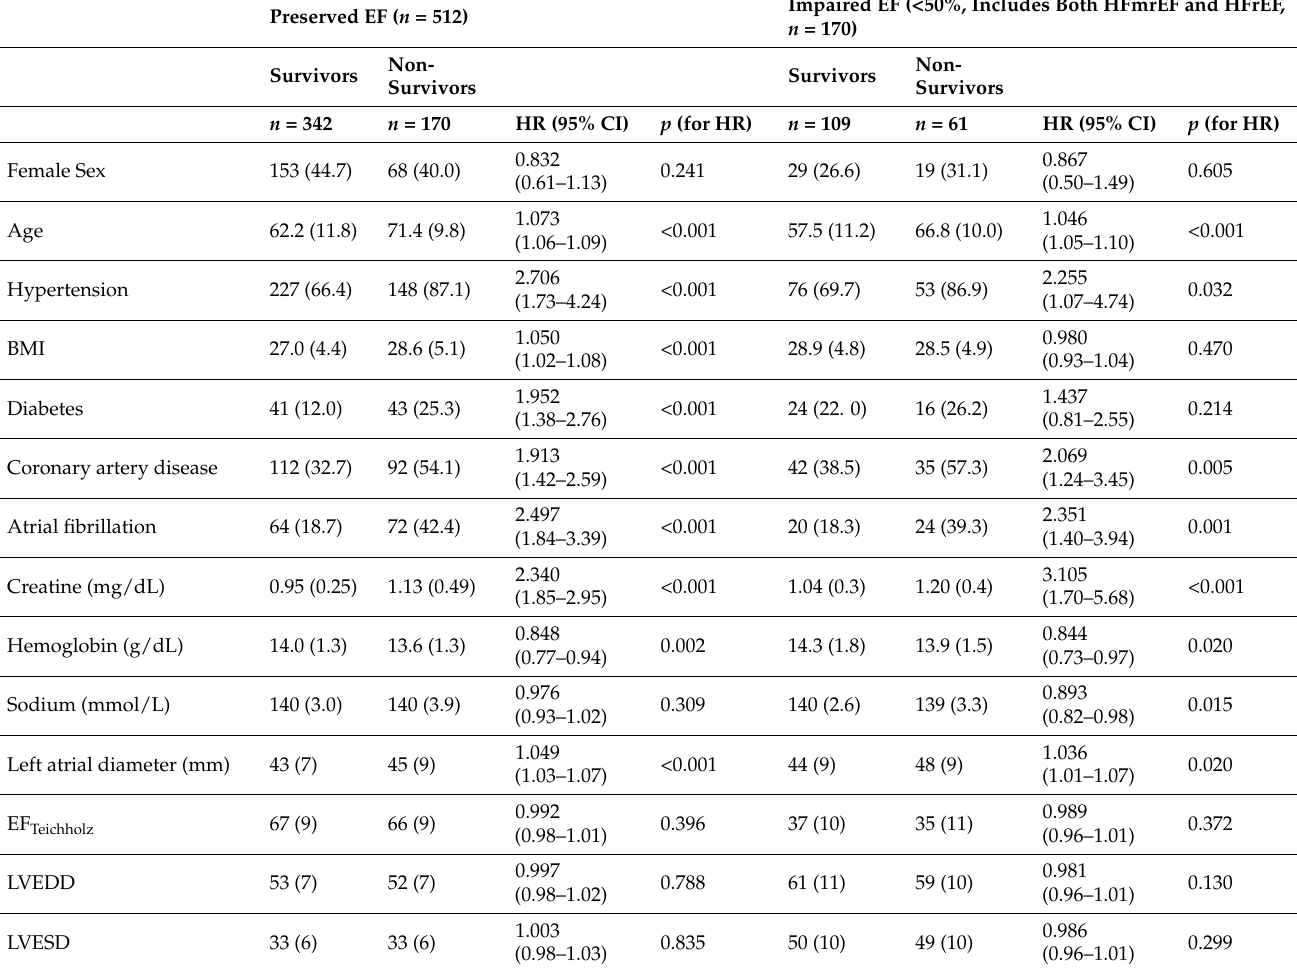
BMI: body mass index, LVEDD: left ventricular end-diastolic diameter, LVESD: left ventricular end-systolic